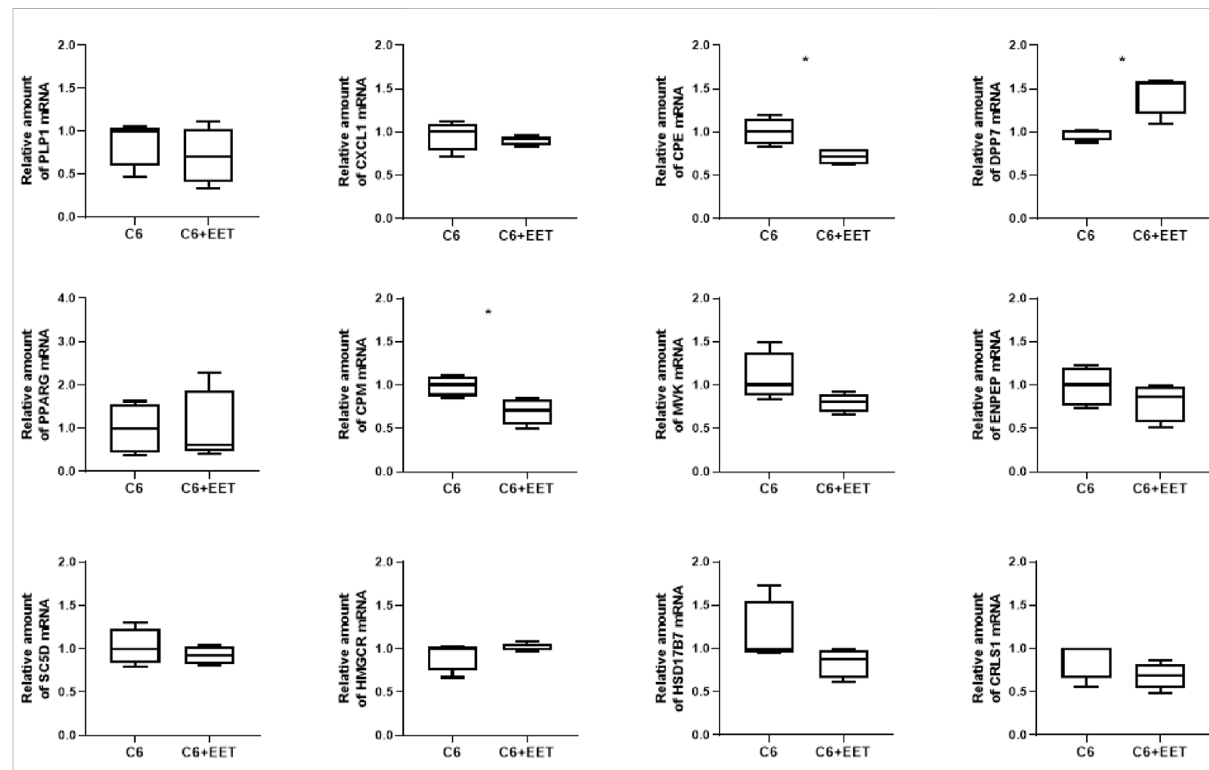
FIGURE 3 Oxylipins regulatesTAZ dependent gene expressionin C6 cells: Relative gene expression of C6 cells treated with ethanol (control) and C6 cells with 3 μ M EET incubated at 37 ° C for 24 h. The amount of Mrna is determined by qpcr that is normalized to RPL13a. Data is represented as boxplot with median, quartile and interquartile range. Asterisks represent signi fi cant